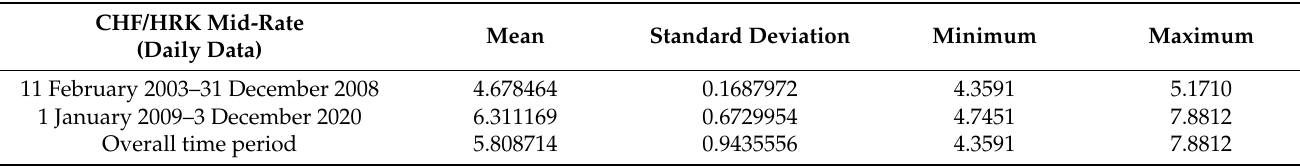
Table 1. Swiss franc to the Croatian kuna (CHF/HRK) foreign currency (FX) mid-rate descriptive statistics, daily data for